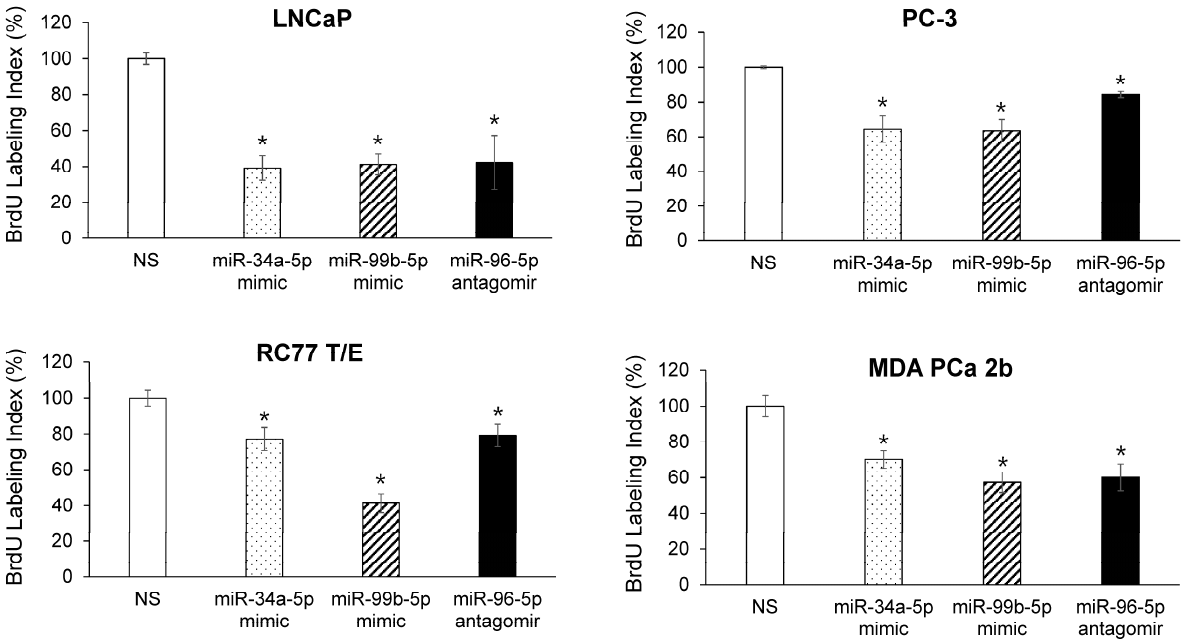
Figure 7. Overexpressing AA-depleted miRNAs or suppressing AA-enrich miRNA causes inhibition of cell proliferation in EA and AA PCa cell lines. BrdU-labeling assays were performed after PCa cell lines were transfected with NS, miR-34a-5p mimic, miR-99b-5p mimic or miR-96-5p antagomir for 48 h. Data were plotted as mean ± SEM of n = 3–4 independent assays, with 3–4 technical replicates for each independent assay. The significance (* p < 0.05 in miRNA mimic/antagomir vs. NS) was determined based on ANOVA with Dunnett post hoc test.